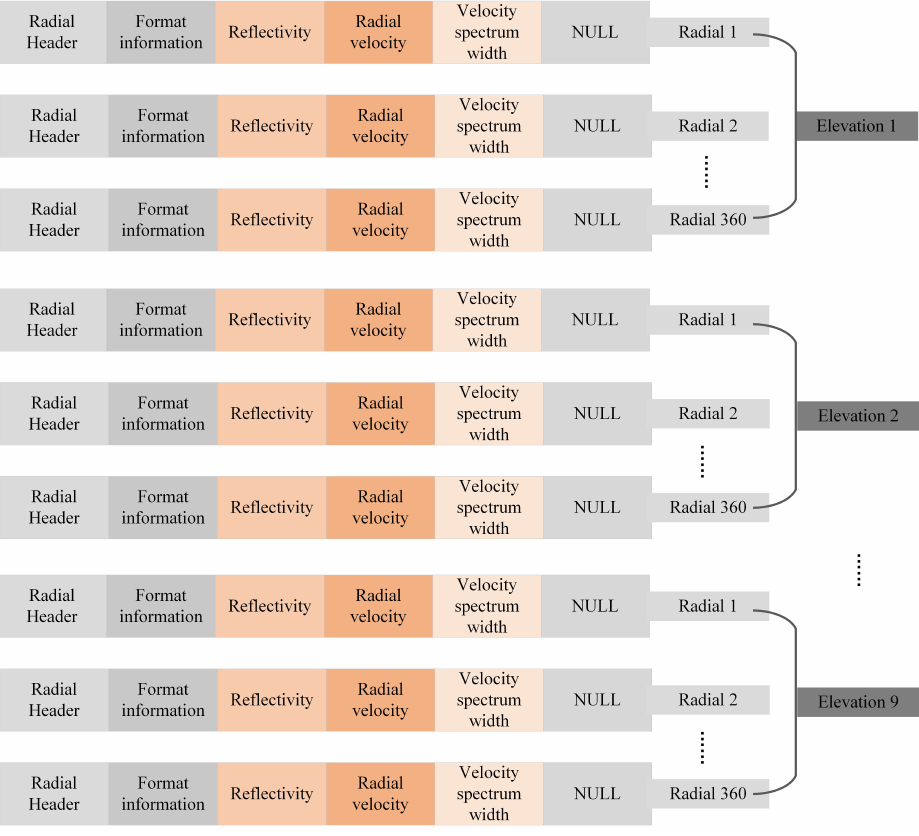
Figure A1. The standard format of CINRAD-SA weather radar. The CINRAD-SA’s Nyquist velocity is 27 m/s, Pulse Repetition Frequency (PRF) 1410 Hz, and Pulse Repetition Time (PRT) 0.709 ms. The radar Level-II data were corrected, including clutter removal and velocity dealiasing. Table A1. The 32 features and their explanations, with the critical 20 features bolded (Z: reflectivity, V: radial velocity, W: spectrum